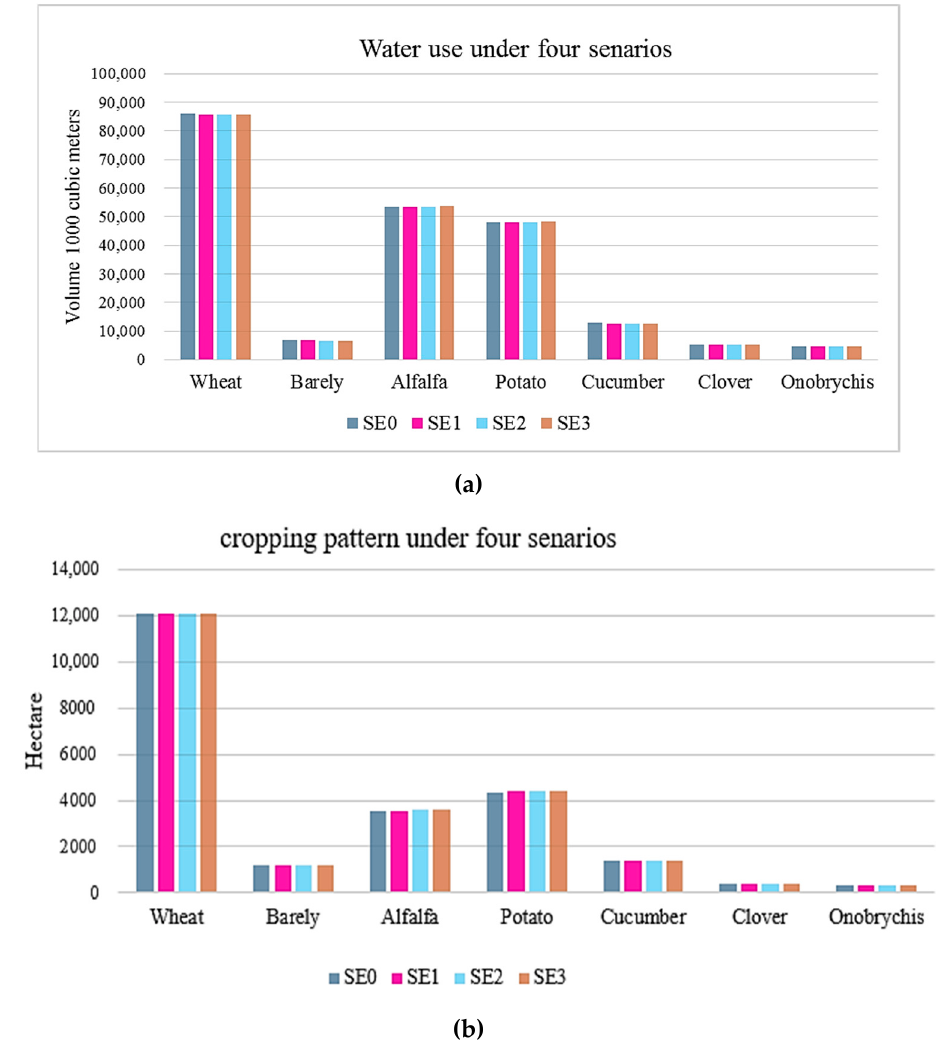
Figure 2. The effect of groundwater pricing scenarios on ( a ) consumed water level and ( b ) Figure 2. The e ff ect of groundwater pricing scenarios on ( a ) consumed water level and ( b ) cultivation cultivation patterns. (See Table A1 for details). patterns. (See Table A1 for